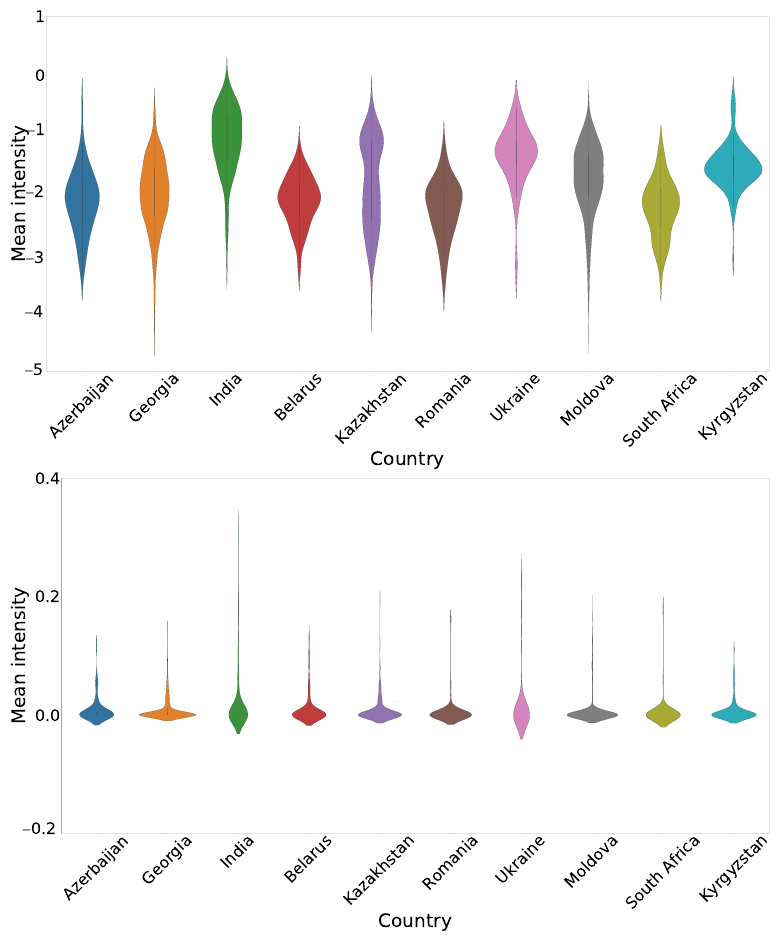
Figure 11. Mean intensity distributions per country for the normalized cropped X-ray images ( top ) and the same images after histogram equalization is applied ( bottom